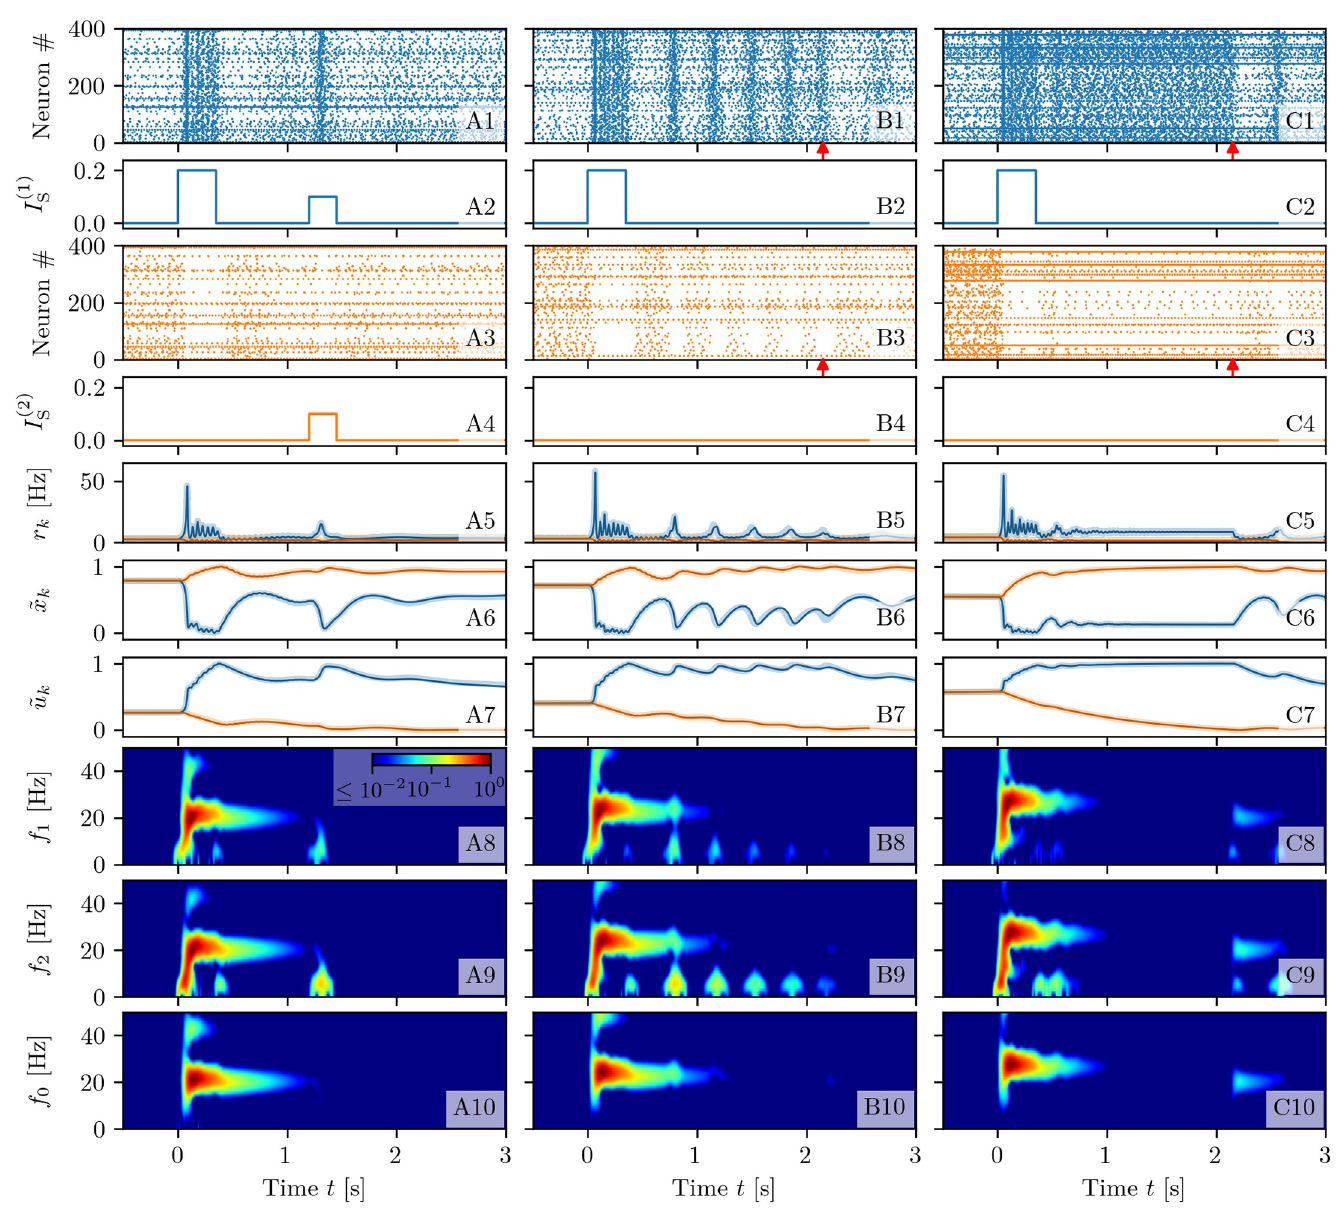
Fig 3. Memory loading, maintenance and rehearsal. The results of three experiments are reported here for different background currents: selective reactivation of the = 1.2, A); WM maintenance via spontaneous reactivation of the target population ( I = 1.532, B) and via a persistent asynchronous activity ( I target population ( I B B C). Raster plots of the network activity for the first (blue, A1-C1 ) and second (orange, A3-C3 ) excitatory population; here the activity of only 400 neurons over 200,000 ones is shown for each population. Profiles of the stimulation current I ð k Þ ð t Þ for the first ( A2-C2 ) (second ( A4-C4 )) excitatory population. Population firing rates r k (t) S ( A5-C5 ), normalized available resources ~ x ð t Þ ( A6-C6 ) and normalized utilization factors ~ u ð t Þ ( A7-C7 ) of the excitatory populations calculated from the simulations k k of the neural mass model (solid line) and of the network (shading). Spectrograms of the mean membrane potentials v 1 ( t ) ( A8-C8 ), v 2 ( t ) ( A9-C9 ), and v 0 ( t ) ( A10-C10 ) obtained from the neural mass model; for clarity the frequencies in these three cases have been denoted as f 1 , f 2 and f 0 , respectively. Red arrows in columns (B) and (C) indicate the time t = 2.15 s at which the background current is set to the value I B = 1.2 employed in column (A). The network simulations have been obtained by considering three populations of N = 200, 000 neurons each (for a total of 600,000 neurons) arranged with the architecture displayed in Fig 2. Other parameters: ffiffiffi p ffiffiffi p ffiffiffi p ffiffiffi p ffiffiffi p ¼ 15 ms H ( i ) = H ( e ) = 0, Δ ( i ) = Δ ( e ) = 0.1, J ð c Þ ¼ 5 , J ð s Þ ¼ 35 , J ¼ 13 , J ¼ (cid:0) 16 , J ¼ (cid:0) 14 with a = 0.4. t e a a a a a ie ei ii ee ee m